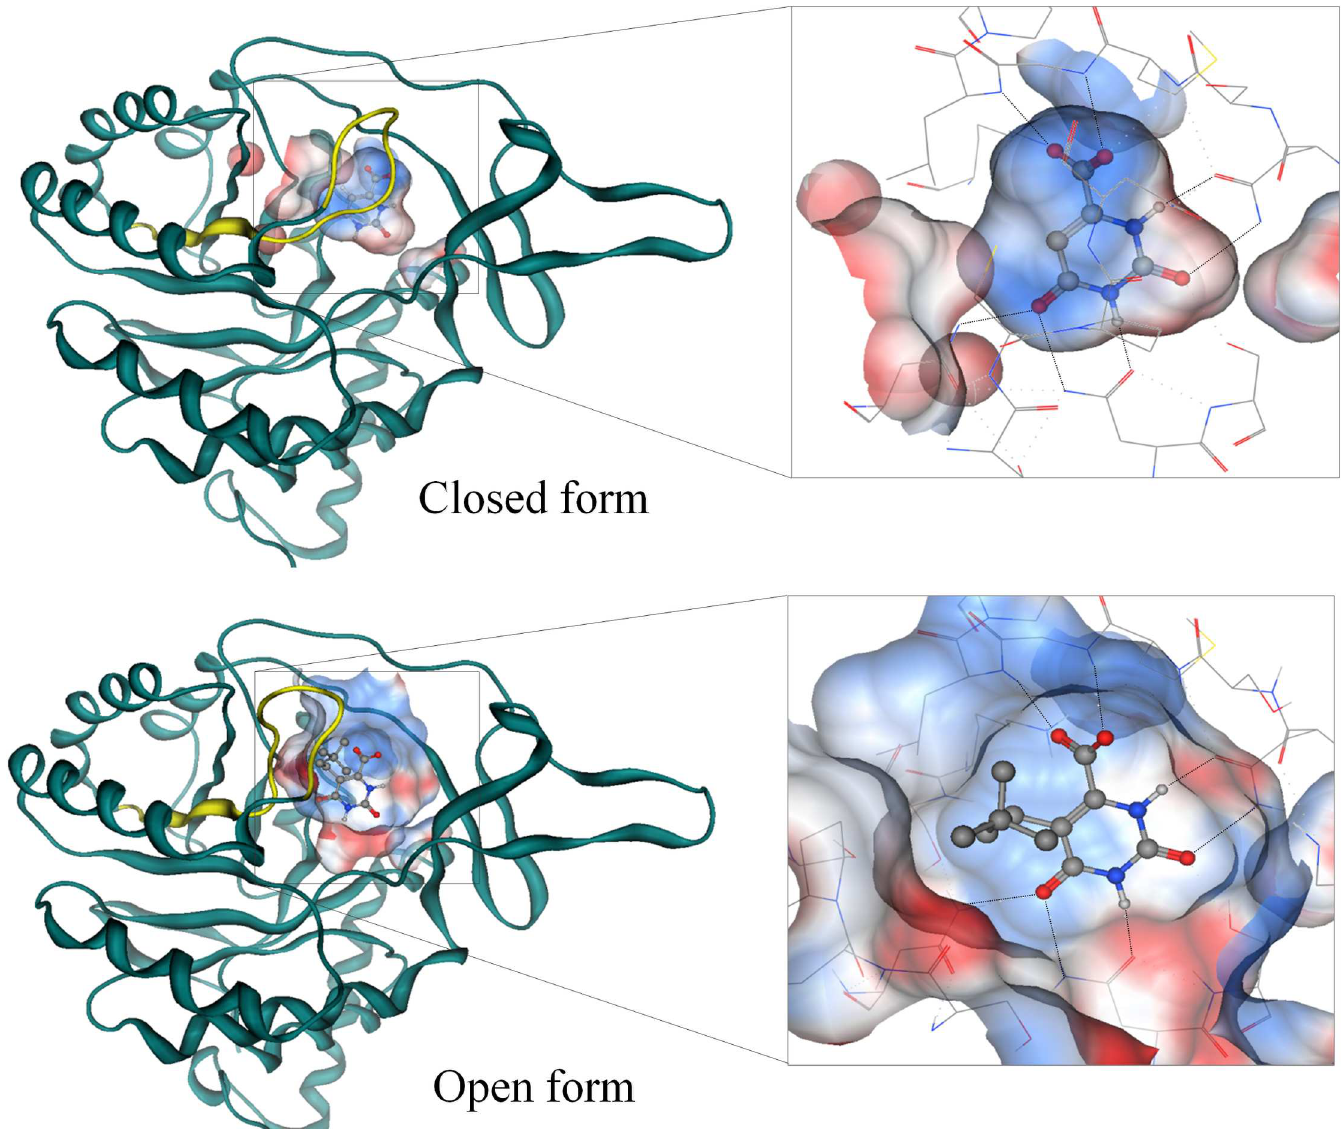
Fig 2. The active site structure upon binding of OF inducer. (Top) Ribbonrepresentation of the TcDHODH structure in complex with orotate (ORO, PDB: 2E6A)[16].(Bottom) Structure of the TcDHODH in complex with 1 (3W1Q). Yellow loop represents the active site loop (S128—V139). A “zoom in” pose of the active site pocket is shown (inset) with hydrogen bonds represented as dotted lines. Ball-and-stick represents ORO and atoms of carbon, nitrogen, oxygen, and hydrogencolored in gray, blue, red, and white,